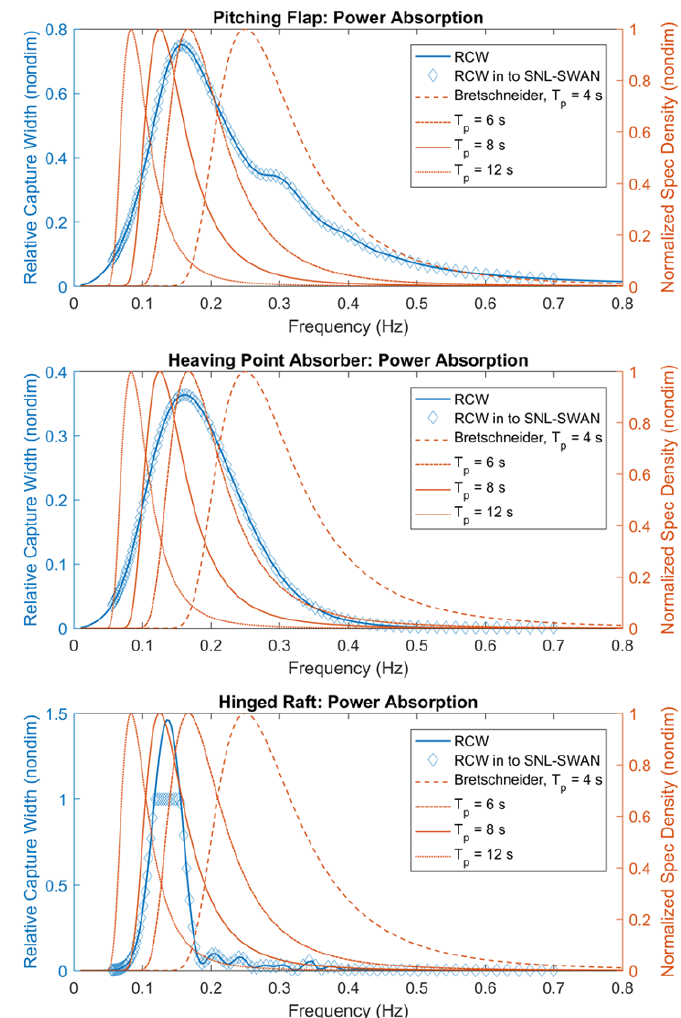
Figure 2. Normalized wave spectra with WEC relative capture width curves: ( top ) pitching flap; ( middle ) point absorber; ( bottom ) hinged